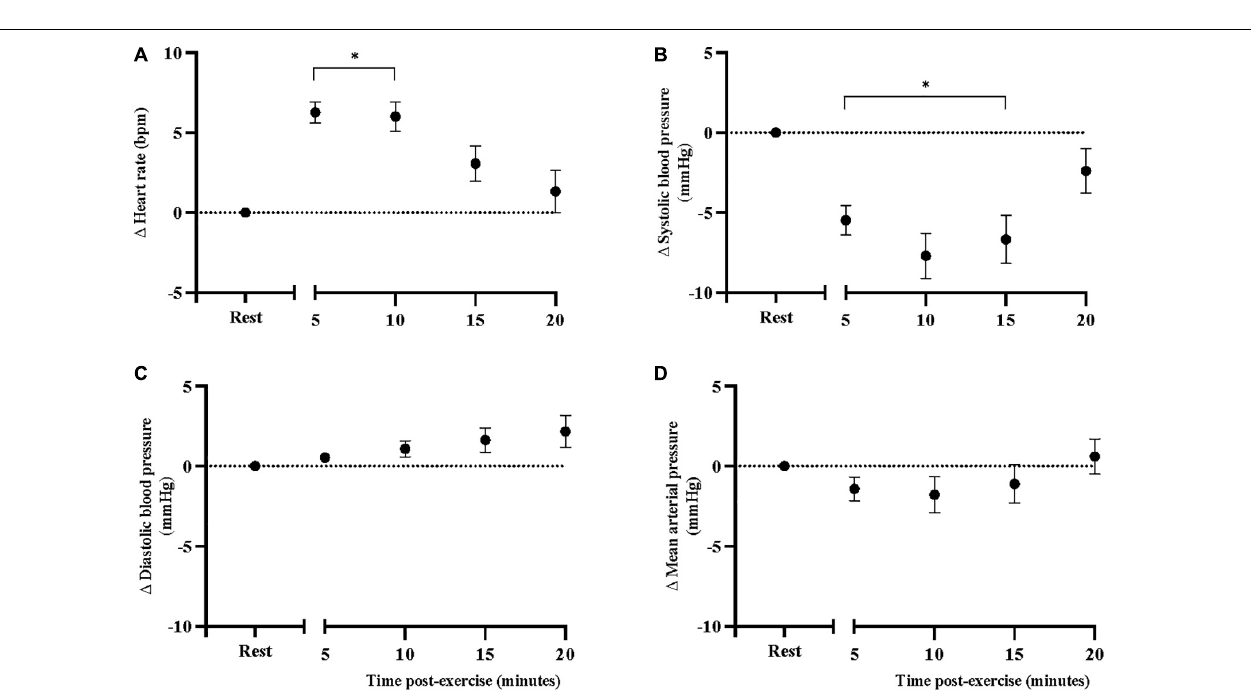
FIGURE 1 | Changes in carotid-femoral pulse wave velocity at rest and after acute, high-intensity aerobic exercise. Points are presented with standard error. Significantly different from resting values * P < 0.05.